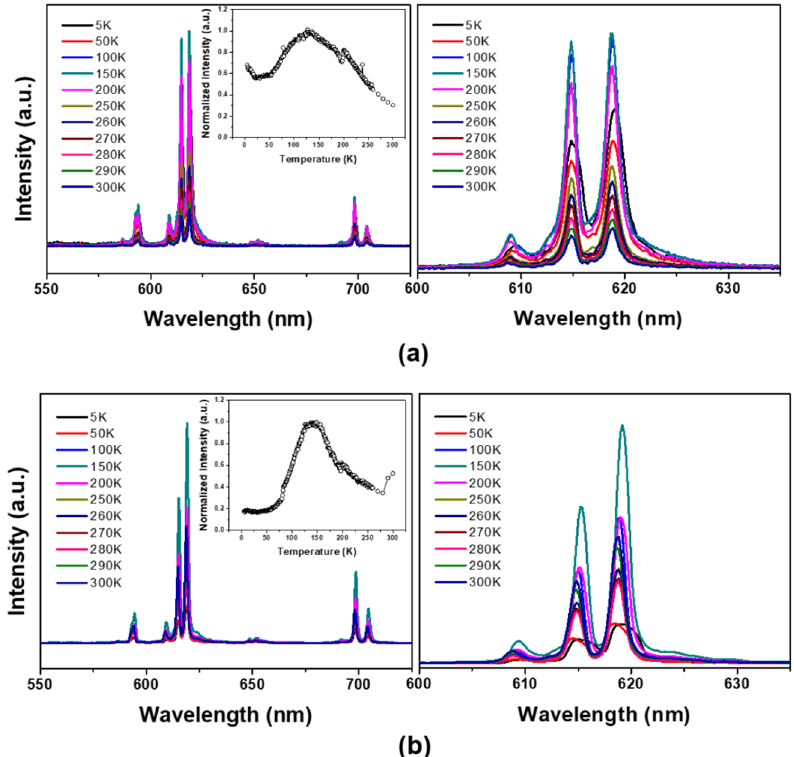
Figure 4. Temperature dependent PL spectra of YVO 4 :Eu 3+ nanophosphors hydrothermally grown using the precursor solutions at ( a ) pH = 7 and ( b ) pH = 10. Corresponding intensity change of 5 D 0 7 F 2 transition (inset image) and enlarged emission spectra are also presented.